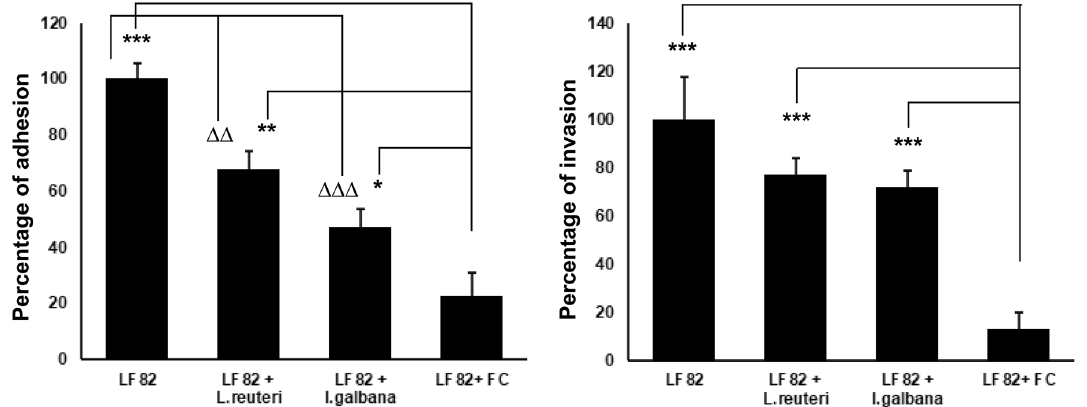
Figure 4. FC reduced the adhesiveness and invasiveness of AIEC LF82 to CACO2 cells. FC significantly reduced the adhesion and invasion of AIEC LF82 to CACO2 cells compared to the probiotic L. reuteri and microalga I. galbana alone. AIEC adherent invasive Escherichia coli , CACO2 human colorectal adenocarcinoma cell line, FC fermented compound, L. reuteri Lactobacillus reuteri , I. galbana Isochrysis galbana */ ∆ P < 0.05; **/ ∆∆ P < 0.01; ***/ ∆∆∆ P <